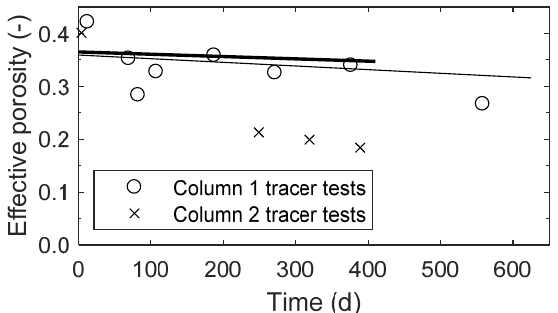
Figure 4. Reduction of effective porosity in column tests. Effective porosity determined by experimental tracer tests is indicated by marks. Experimental tracer test marks are compared with the theoretical porosity reduction predicted by calculation of volume occupied by precipitates, indicated by the descending slope of the thin line (column 1) and of the thick line (column 2).